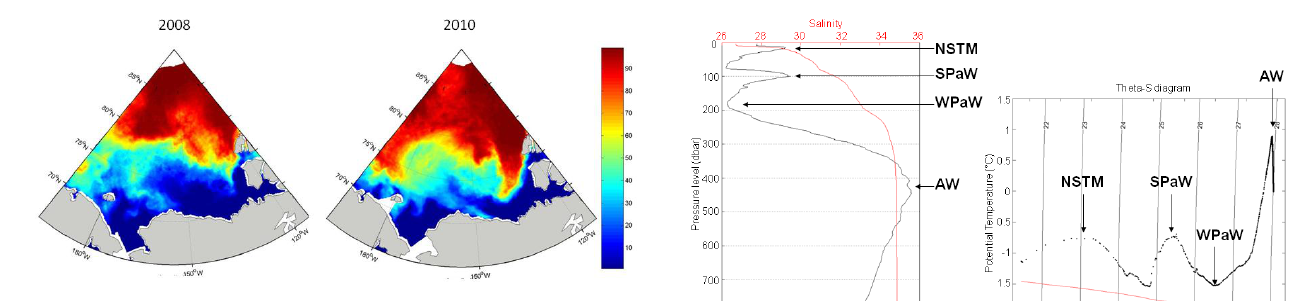
Figure 5: Mean summer (July, August, September) sea ice concentrations in percent, in 2008 Fig. 5. Mean summer (July, August, September) sea ice concentra- (left) and 2010 (right), obtained from the AMSR-E data. tions in percent, in 2008 (left) and 2010 (right), obtained from the AMSR-E data.